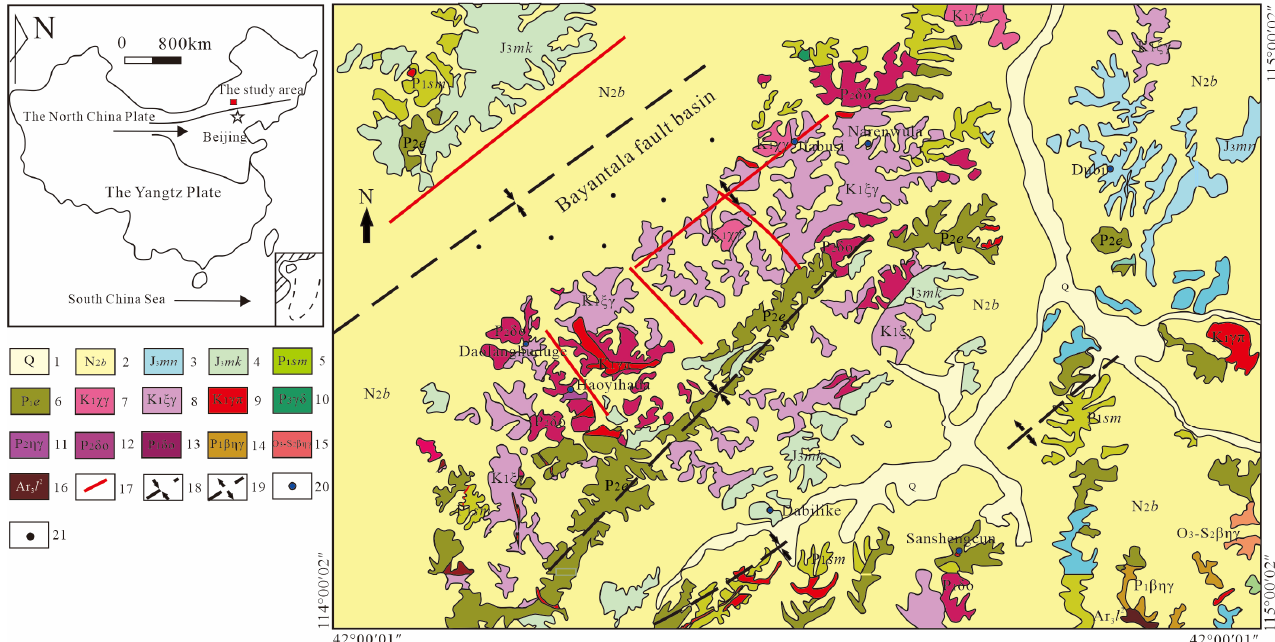
Figure 1. Generalized geologic map of the study area. Note: 1. Quaternary; 2. Baogedawula For- mation, Pliocene Series, Neogene; 3. Manitu Formation, Upper Jurassic Series; 4. Manketouebo Fro- mation, Upper Jurassic Series; 5. Sanmianjing Formation, Lower Permian Series; 6. Elitu Formation, Upper Permian Series; 7. Early Cretaceous alkali-feldspar granite; 8. Early Cretaceous syenogranite; 9. Early Cretaceous granite porphyry; 10. Late Permian granodiorite; 11. Middle Permian monzo- nitic granite; 12. Middle Permian quartz diorite; 13. Early Permian quartz diorite; 14. Early Permian monzonitic granite; 15. Late Ordovician-Middle Silurian monzonitic granite; 16. Neo-Archean Liushugou Formation; 17. fault zone; 18. syncline; 19. anticline; 20. W-Nb-Ta-F deposit; 21. U-min- eralized deposit. The study area is located in Inner Mongolia, North China, as shown in the over- view.